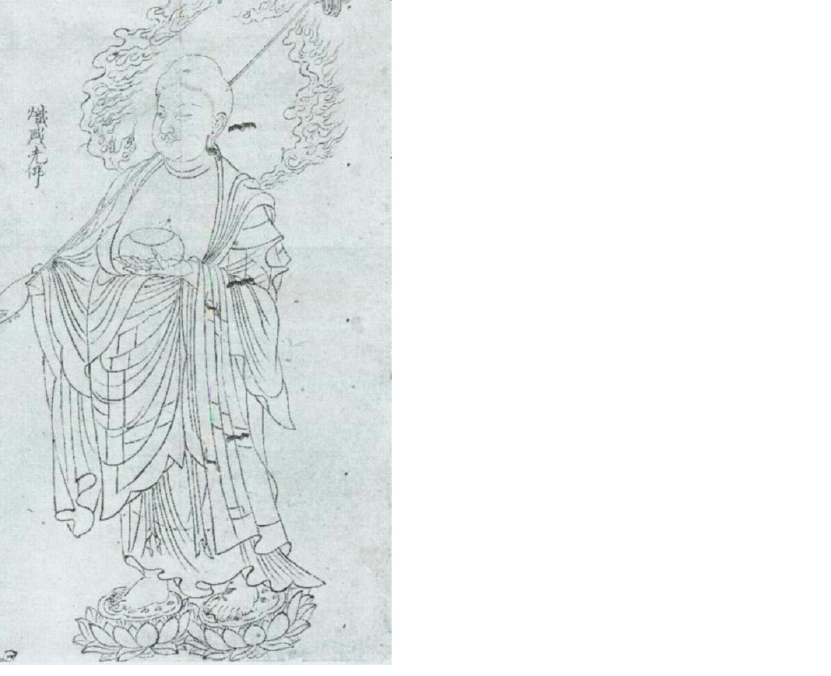
Figure 10. Images of Nine Luminaries (Tejaprabh ā Buddha), MOA Museum of Art, Ink on paper, 353.6 × 28.8 cm, 1164.